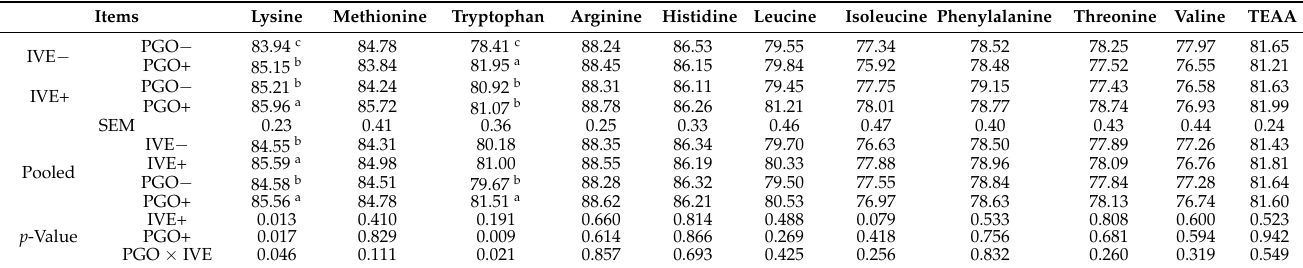
Table 4. Effect of probiotics with added glucose oxidase (PGO) and Illicium verum extracts (IVE) on EAA digestibility of weaned piglets 1 ,